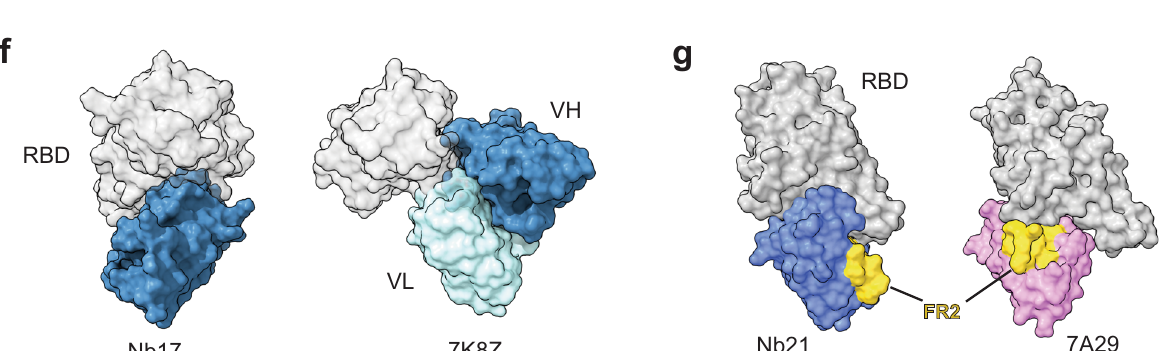
Fig. 7 Comparisons of RBD neutralizing Nbs and mAbs. a Buried surface areas of RBD: Nb and RBD: Fab complexes. VH heavy chain, VL light chain. b Buried surface areas per-interface residue for Nbs and Fabs. c The contact contribution of CDRs and FRs of Nbs and Fabs in RBD binding (using a 6 Å cutoff). Contact contribution % was calculated as # of contacting residues on CDR or FR region/total # of contacting residues. d Quanti fi cation of interface cavity. Y -axis is the curvature value. ( n = 25 and 60 for Nbs and Fabs, respectively). Box plots indicate median (middle line), 25th, 75th percentile (box), and 5th and 95th percentile (whiskers) as well as outliers (single points). Statistical analysis was performed using a two-tailed student t test, * p <